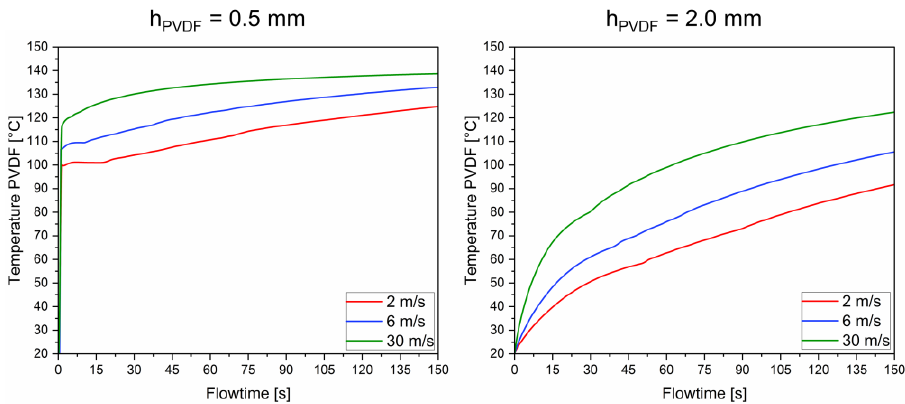
Figure 5. Evolution of the average PVDF shell temperature. The temperature is calculated for different shell thicknesses of 0.5 and 2.0 mm and working fluid velocities (2, 6 and 30 m/s).